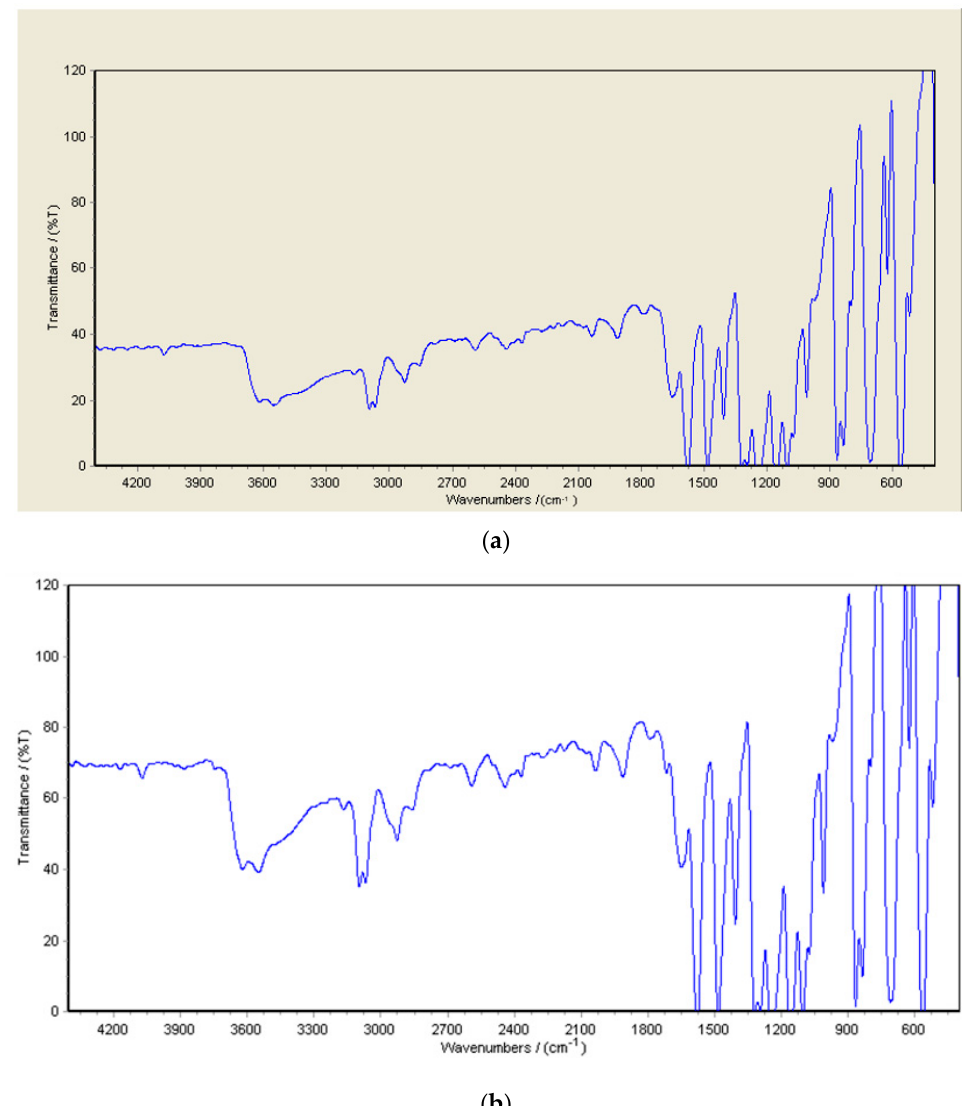
Figure 2. FTIR spectra of ( a ) PSF and ( b ) modified membrane with GO/Pt (0.75 wt%) nanoparticles.